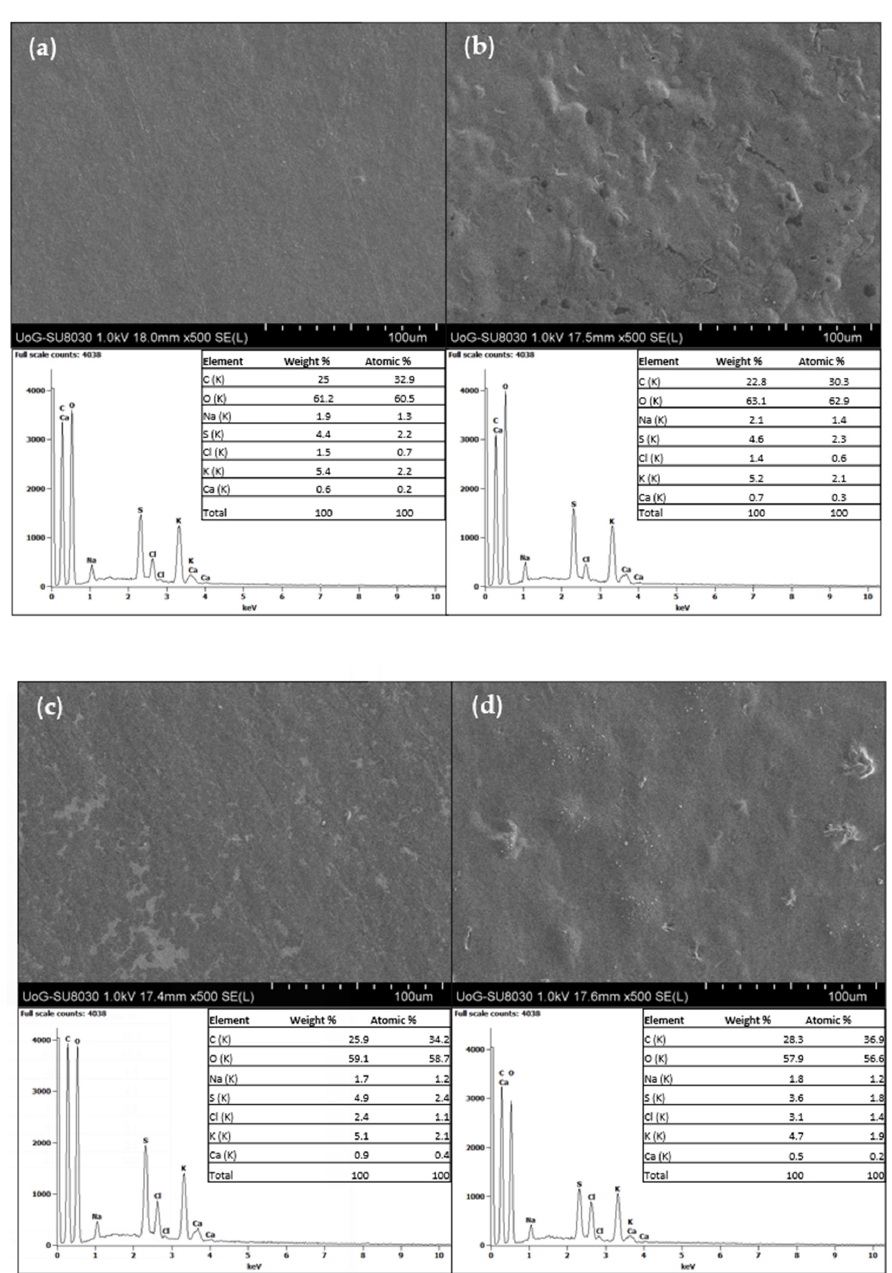
Figure 2. SEM images ( × 500) and EDX analysis of the ( a ) Car/Alg/Pol, ( b ) Car/Alg/Pol-Cur, ( c ) Car/Alg/Pol-Dlf, ( d ) Car/Alg/Pol-Cur+Dlf films. The Car/Alg/Pol film (Figure 2a) had a smooth, homogeneous, and uniform surface, indicating the excellent film formability of carrageenan, alginate and poloxamer. Mean- while, the Car/Alg/Pol-Cur film presented somewhat uneven surfaces (Figure 2b). Some convex pieces and crystalline particles were observed on the surface when the curcumin was added to the film. Observation of the surface of Car/Alg/Pol-Cur (Figure 2b) reveals crystals that are embedded into the polymer matrix. This can be explained by the fact that